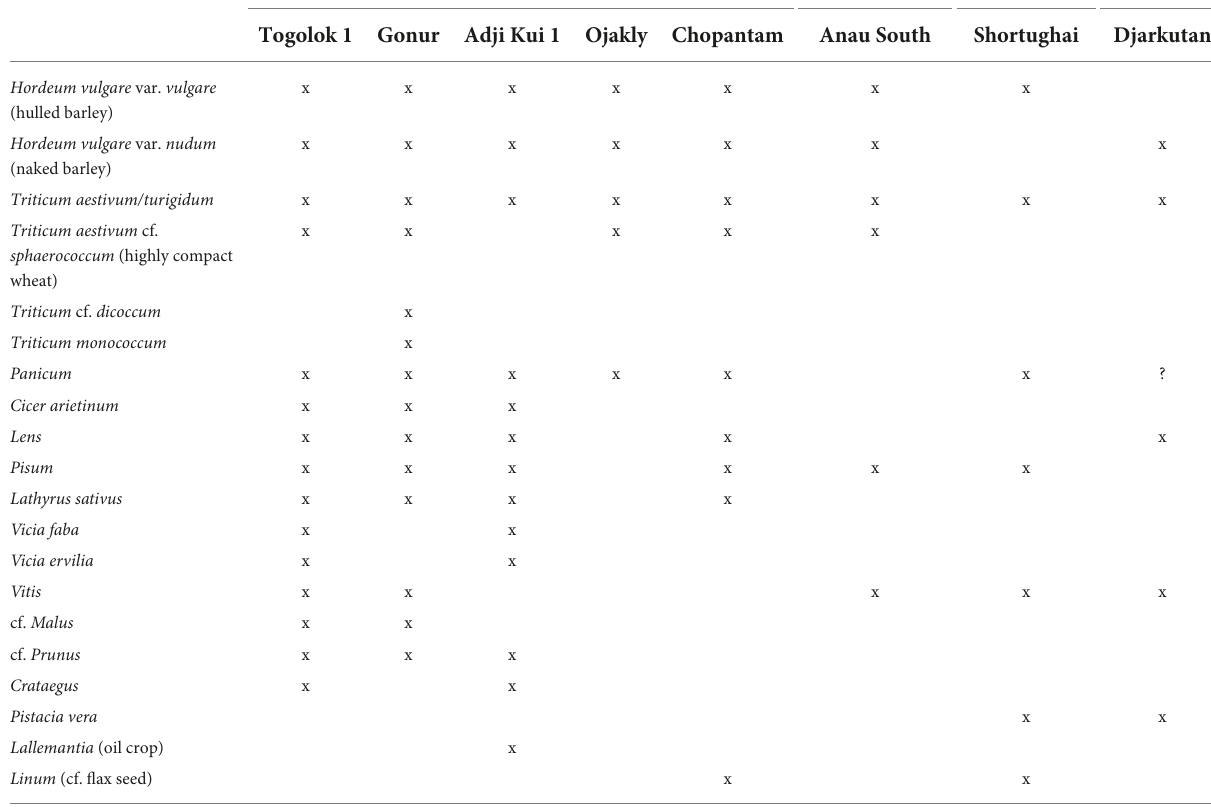
TABLE 2 Presence/absence of key economic species from second millennium B.C. contexts at archaeological sites in Turkmenistan, Uzbekistan, and northern Afghanistan. Plant